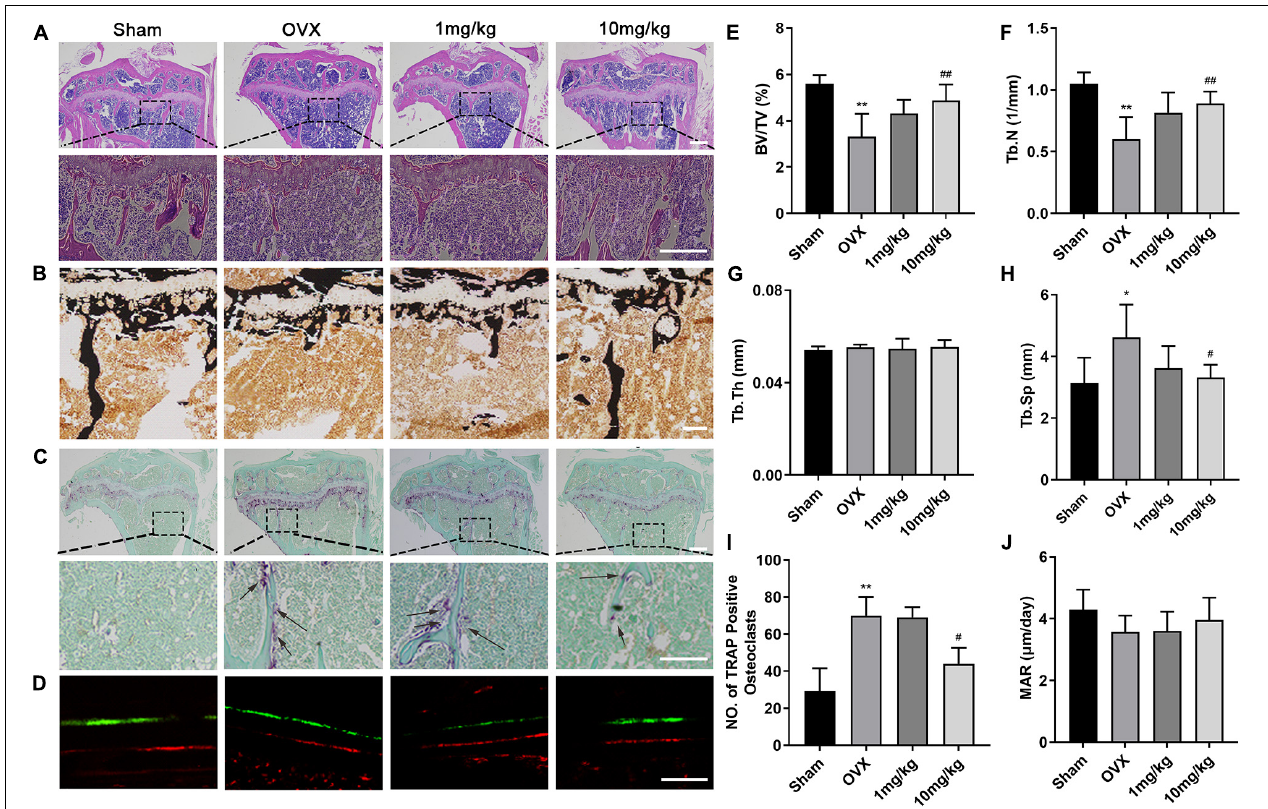
FIGURE 6 | Histological and histomorphometric assessment of the effects of GKA on OVX-induced bone loss. (A) Representative histological assessment of tibial bone sections from mice in sham, OVX, low, and high groups stained with hematoxylin and eosin (H&E) (scale bar, 200 µ m). (B) Microscopic images of longitudinal sections stained with von Kossa (scale bar, 50 µ m). (C) Representative image of tibial bone from sham, OVX, low, and high groups stained with TRAP (scale bar, 200 µ m). (D) Representative images of calcein and Alizarin Red (scale bar, 50 µ m). (E–H) Histomorphometric parameters of BV/TV, Tb.N, Tb.Th, and Tb.Sp. (I) Quantitative assessment of the total numbers of TRAP + osteoclasts. (J) Histomorphometric parameters of calcein-labeled sections, MAR (mineral apposition rate). The data were presented as the mean ± SD (* P < 0.05, ** P < 0.01 relative to the sham group, # P < 0.05, ## P < 0.01 relative to the OVX group, analyzed by one-way ANOVA, followed by multiple comparisons per test; n =